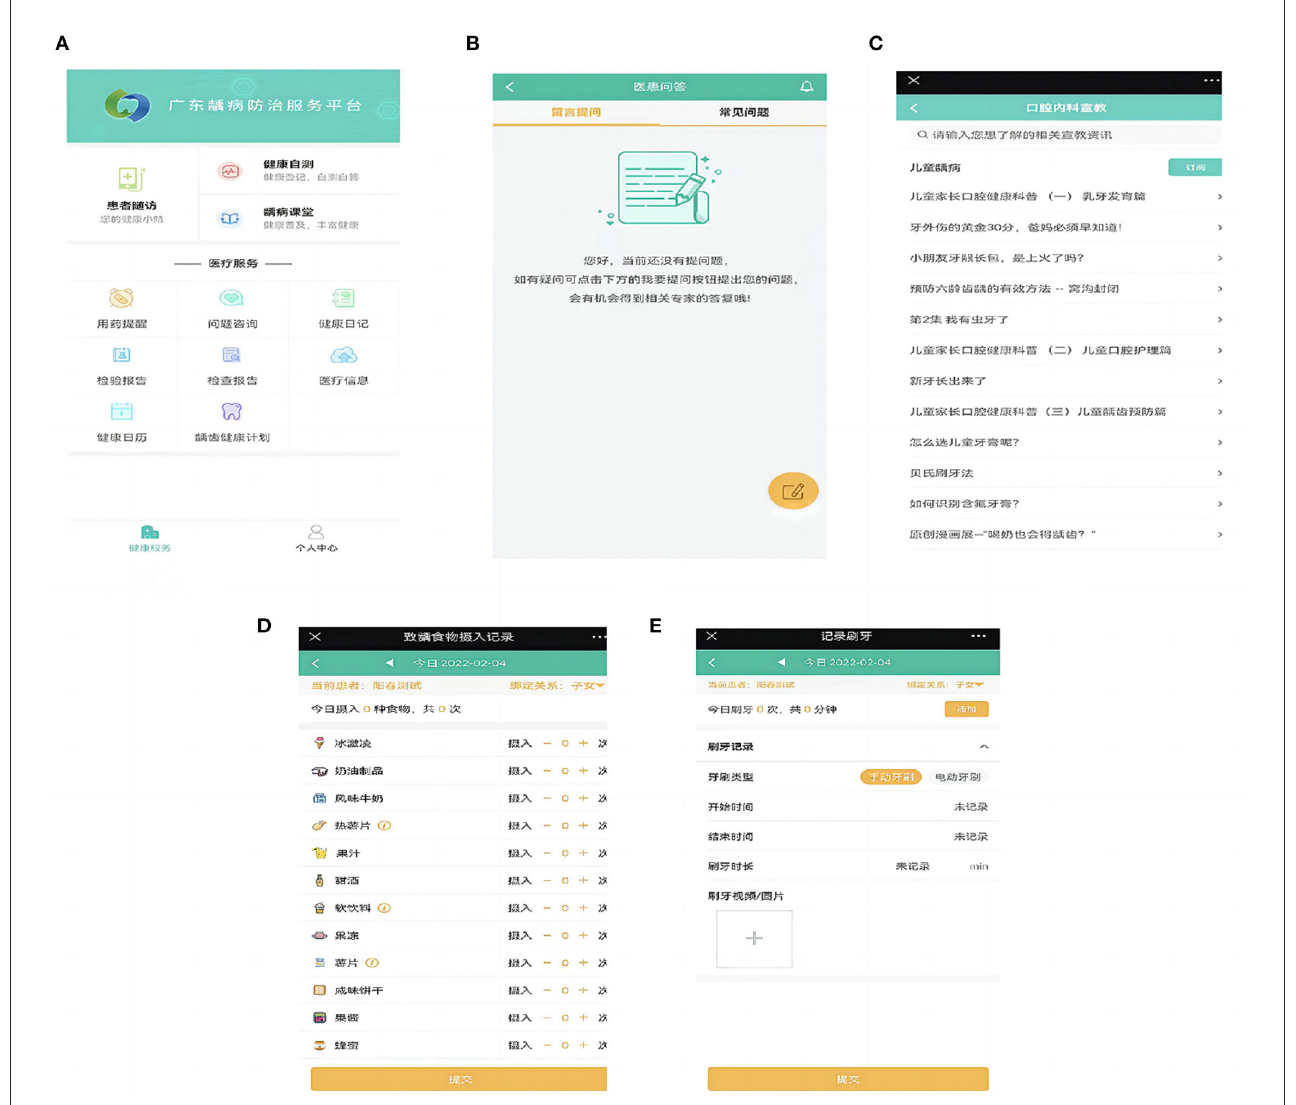
FIGURE3 Functions of patients’ mobile terminal. (A) Main interface of patients’ mobile terminal; (B) Doctor-patient question answering system; (C) Health education; (D) Diet monitoring; (E) Teeth brushing